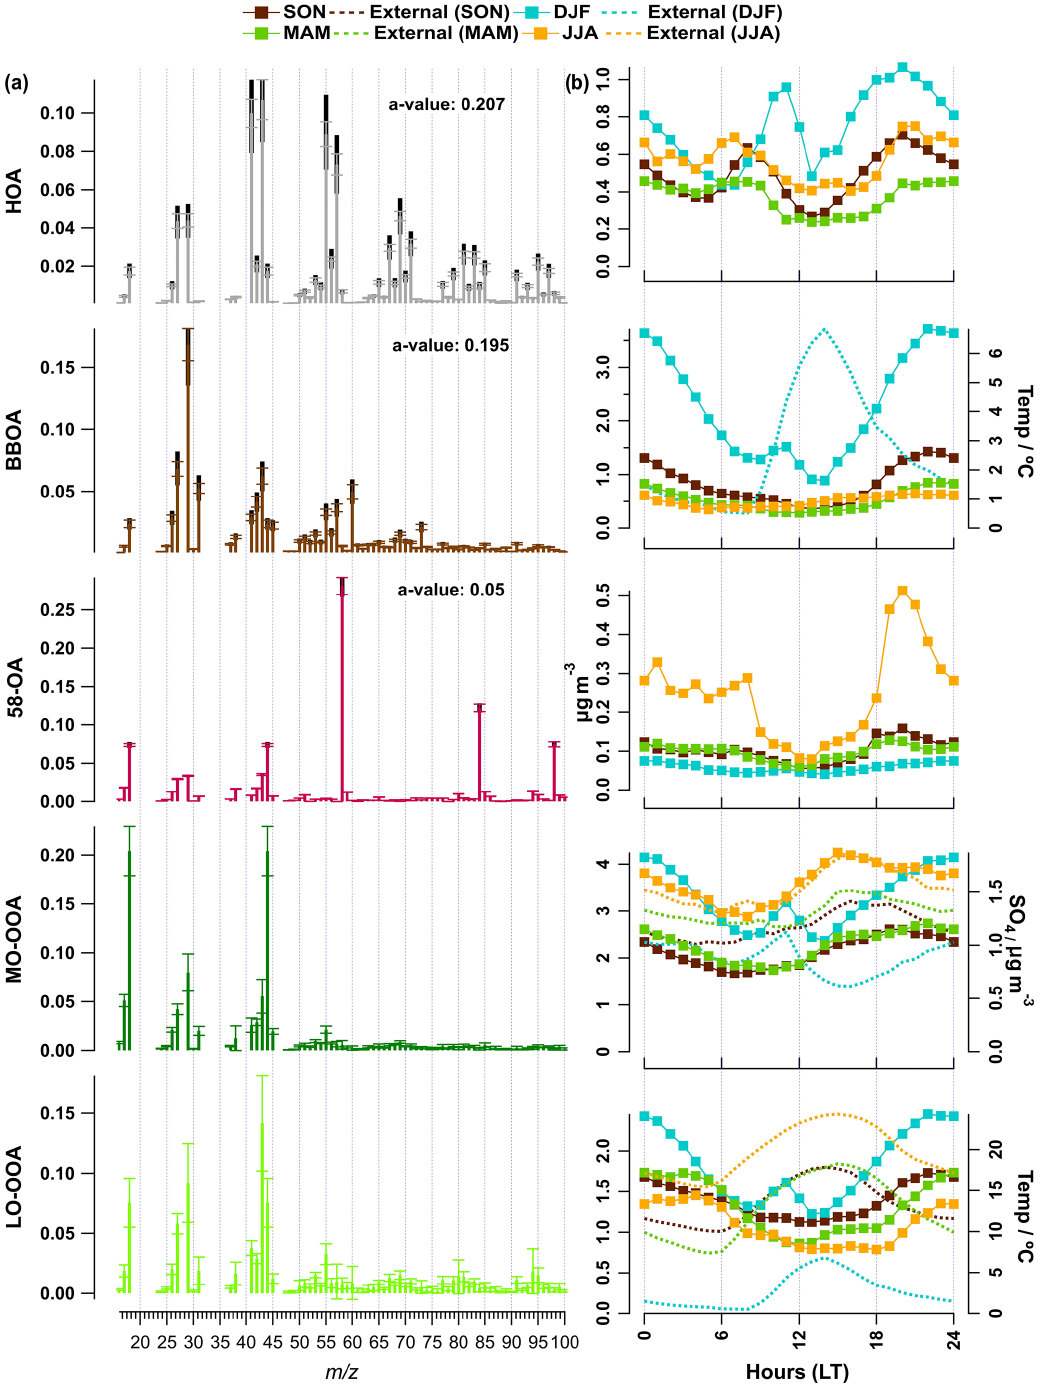
Figure 5. Overview of the primary and secondary OA components in Magadino in 2013–2014: (a) OA factor profiles and (b) seasonal diurnal cycles of HOA, BBOA, 58-OA, MO-OOA, and LO-OOA. The ambient temperature is shown in the LO-OOA diurnal plots. In (a) the error bar is the standard deviation; the black bars show the maximum and the minimum that the variable was allowed to vary from the reference profiles. The average, 10th, and 90th percentiles for a values of HOA are 0.195, 0.007, and 0.378, respectively. Also, the average, 10th, and 90th percentiles for a values of BBOA are 0.202, 0.025, and 0.379,